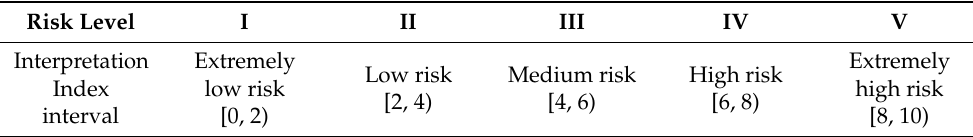
Table 2. Standard for fire risk assessment level of the urban utility